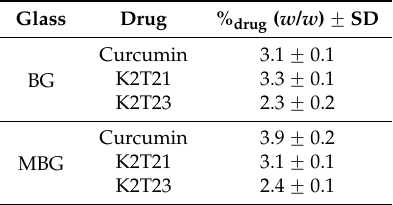
Table 2. Percentage ( w / w ) of the loaded drug on the glass delivery system via evaporation method (SD = standard deviation obtained by three different replicate determinations).